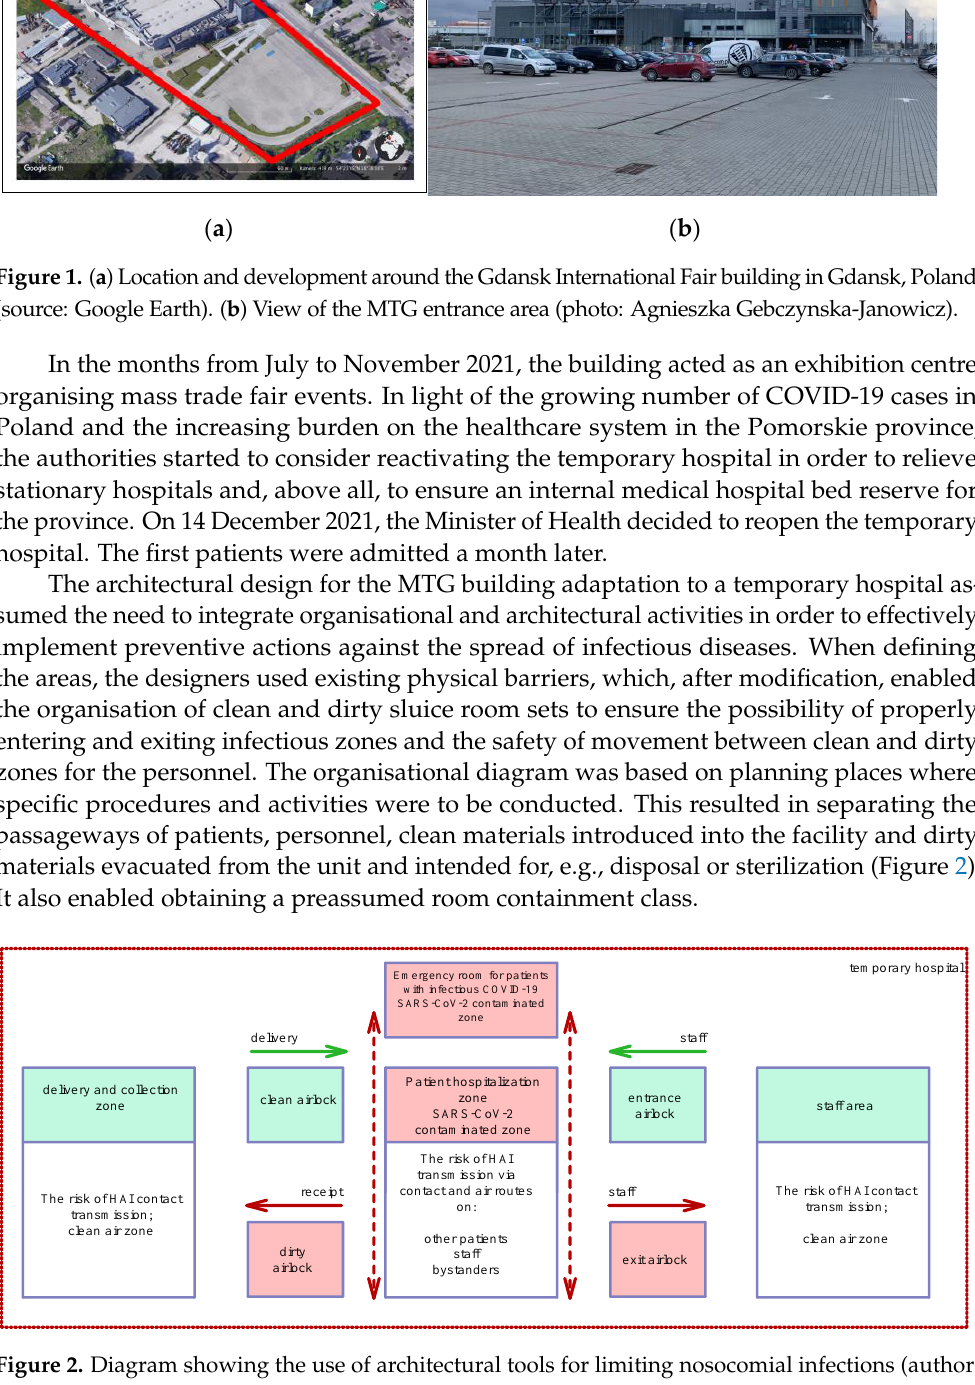
Figure 2. Diagram showing the use of architectural tools for limiting nosocomial infections (author: Rafal Janowicz).